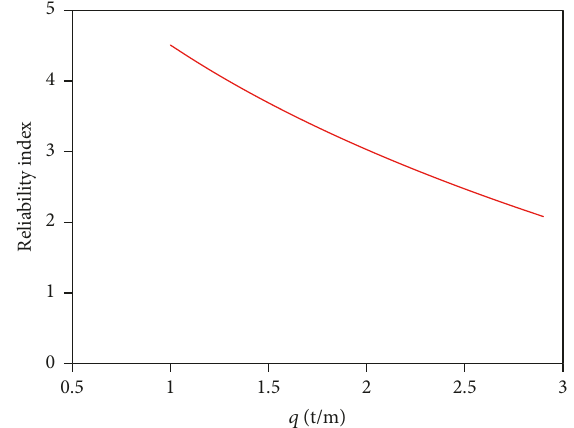
Figure 4: Reliability index with respect to load ( q ) for Example 1.